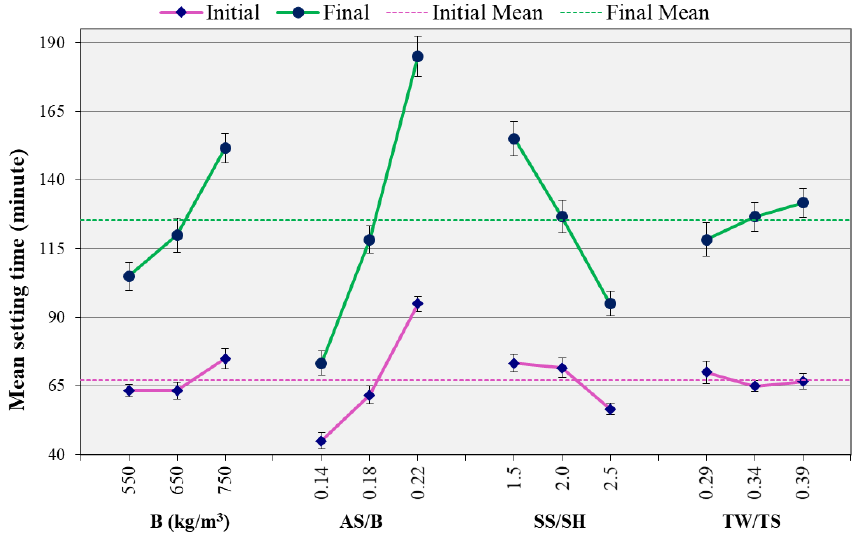
Figure 2. The effect of parameters on the setting time.